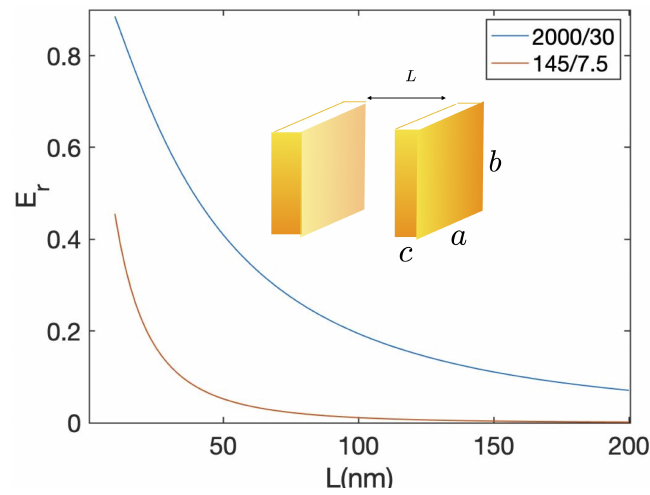
Figure 1. The energy ratio, E r , for two sizes of square plates of size a = b and thickness c . The lines correspond to the value a / c as indicated. The sizes correspond to those used in Refs. [16,17]. See text for details.